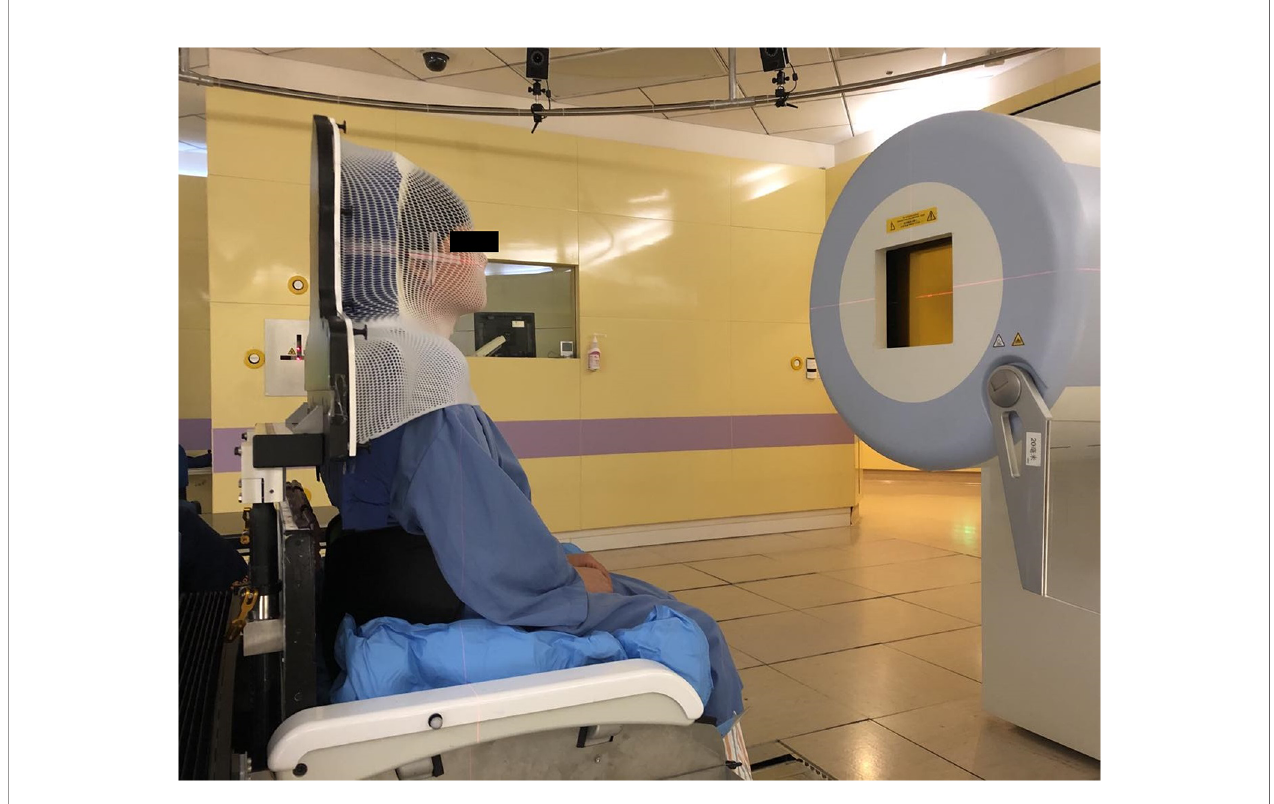
FIGURE 2 | The patient setup on the